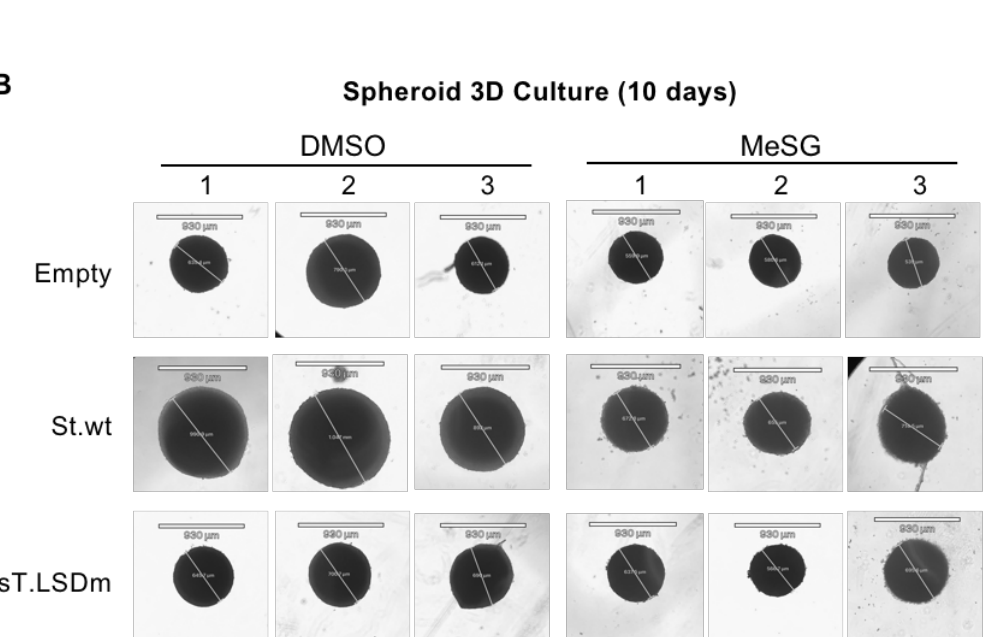
Figure 4. MeSG inhibits sT-induced cell proliferation. ( A ) Effects of MeSG on cell proliferation of NIH3T3 cells-expressing MCPyV sT were determined by CCK8 cell proliferation assay. NIH3T3 cells were transduced with lentivirus expressing empty vector, sT, or sT LSD mutant (st.LSDm) and treated with MeSG for 24 h. Small T-expressing cells are specifically sensitive to MeSG treatment, inhibiting cell growth. ( B ) Spheroids are generated in a cell-repellent tissue culture dish and treated with MeSG treatment (1 µ M) for 10 days. The scale bar represents 930 µ m. The spherical-shaped spheroids generally maintained their morphology over time. Images were taken with REVOLVE4 microscope and analyzed ( C ) using Echo Pro software (Echo Laboratories). Data was analyzed via one-way ANOVA (mean ± SEM, n = 3, * p < 0.05, ** p < 0.01, n.s.: not